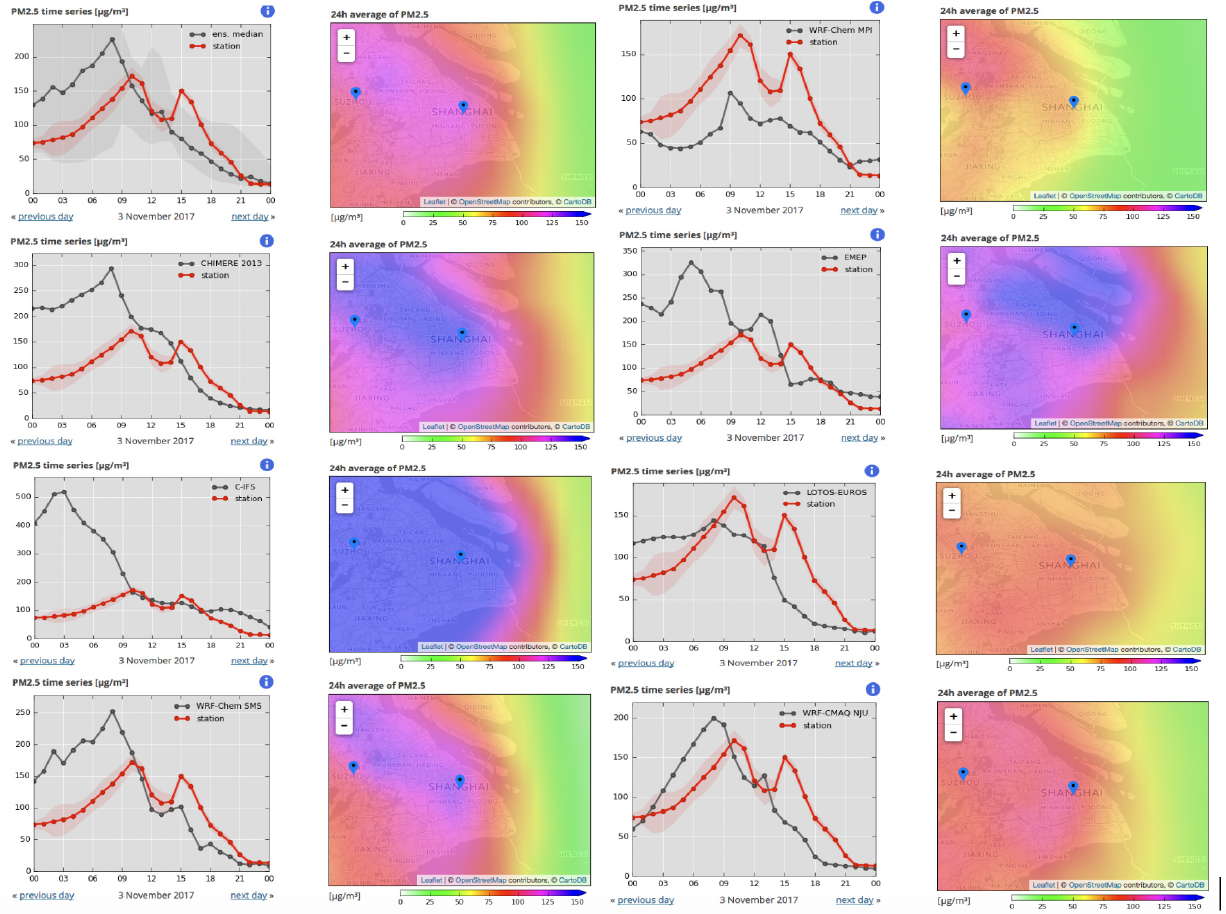
Figure 4. Forecast by different models of PM 2 . 5 concentration during a polluted day in Shanghai on 3 November 2017. The graph in the top panel of the first column represents the median concentration, and the individual forecasts provided by CHIMERE, IFS, WRF-Chem-SMS, WRF-Chem-MPIM, EMEP, LOTOS-EUROS, and WRF–CMAQ are shown by the other panels. Measured concentrations are represented by the red curves and model concentrations by the black